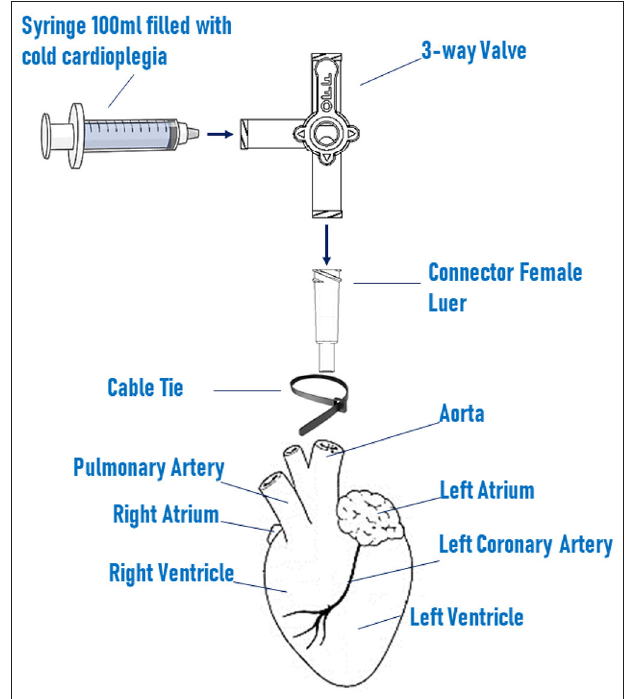
FIGURE 1 | Schematic setting of heart perfusion system. Heart is perfused with cold cardioplegia via a 100ml sterile syringe connected to a the 3-way valve. The valve is screw to a female luer connector, which is inserted in the ascending aorta and fixed in position by a nylon cable tie.